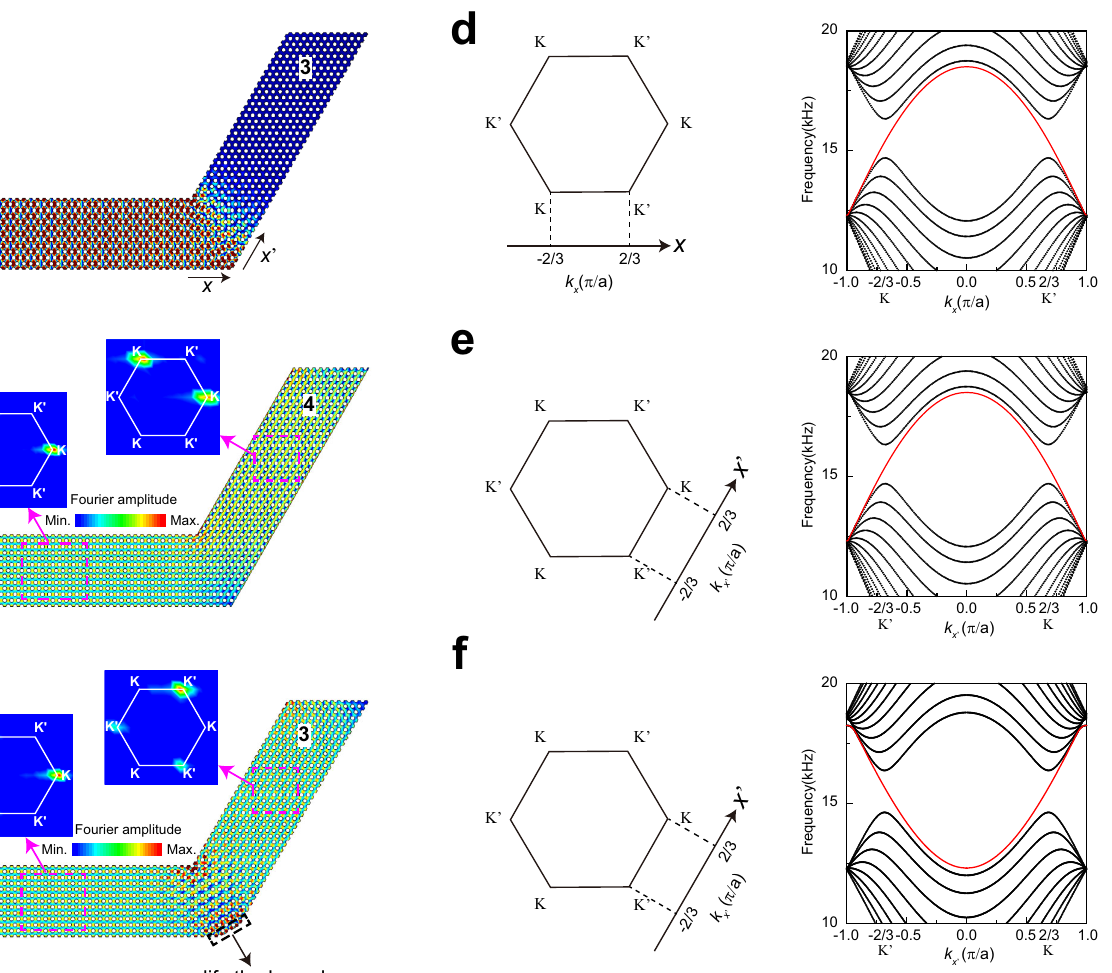
Fig. 4 | Control the transmission of CABSs by adjusting the boundary modi fi cations. a – c Simulated acousticpressure fi elddistributionsat15.5kHzfora pointsourceinthreedifferentcon fi gurationsofthe60-degree-bendPCs.ThePCin a is composed of two waveguides with the same band dispersion (with periodic boundary conditions in the x - and x ′ -directions). The PC in b is composed of two waveguides with inverted K and K ′ valleys in the band dispersion. The width of the waveguide in domain 4 issmallerthan that ofdomain 1 by one layer. The PC in c is composed of two waveguides with the same band dispersion, featuring some Fig. 4b, this is veri fi ed experimentally that the wave (15.5kHz) excited by a source on the left can transmit through the sharp bend and only K valley states are excited in domains 1 and 4 and the K ′ valley states are deeply suppressed.